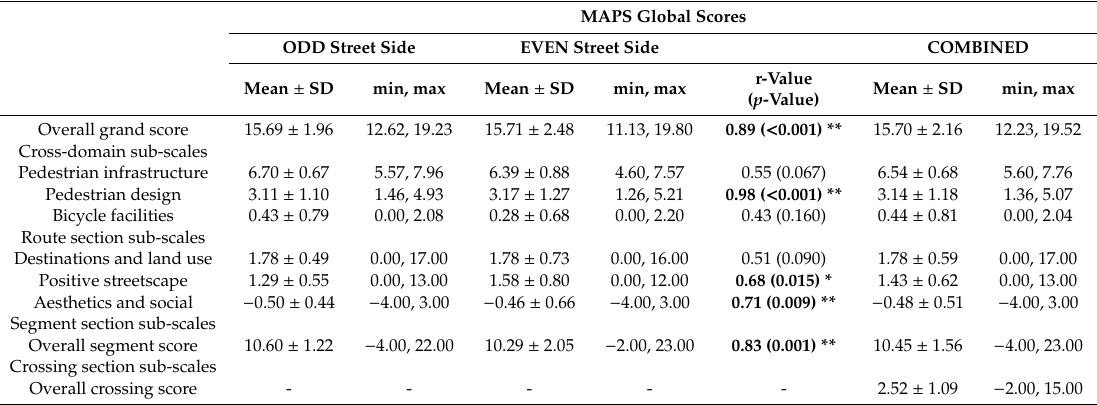
Table 3. MAPS Global sub-scales and scores across odd and even sides of street segments, presented individually and